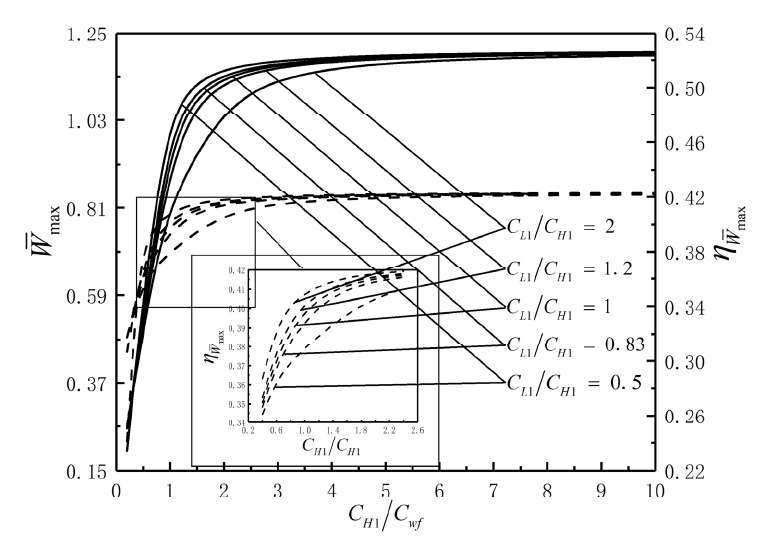
− C H 1 / C wf W max